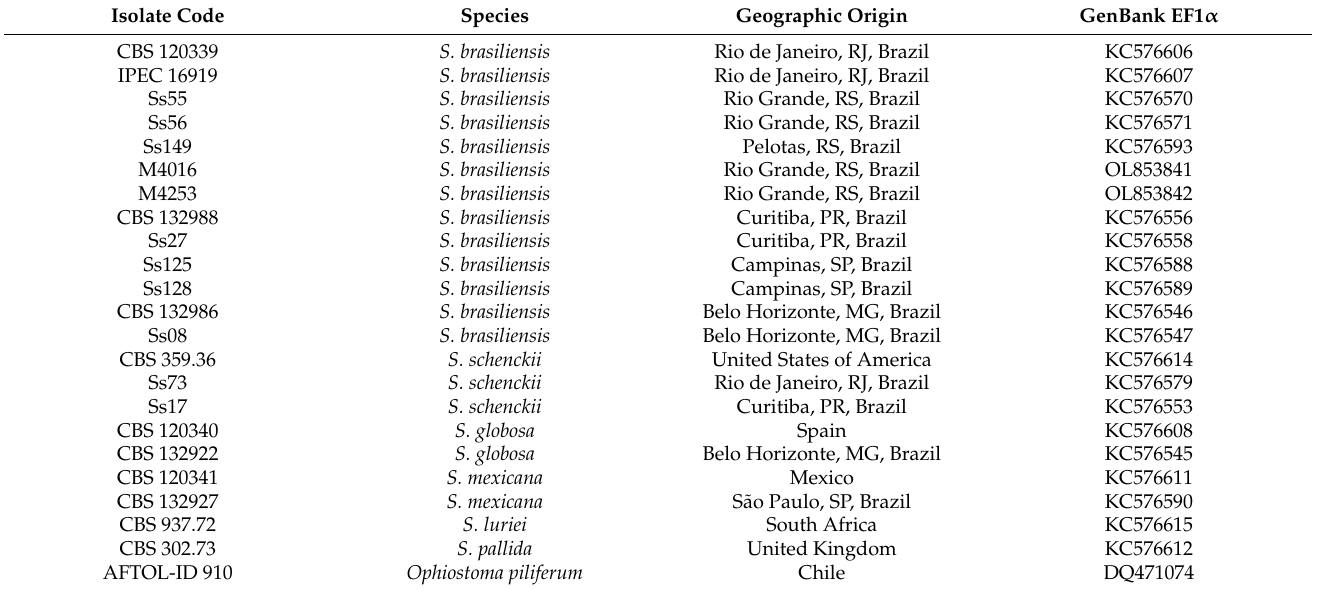
Table 1. Isolates and GenBank